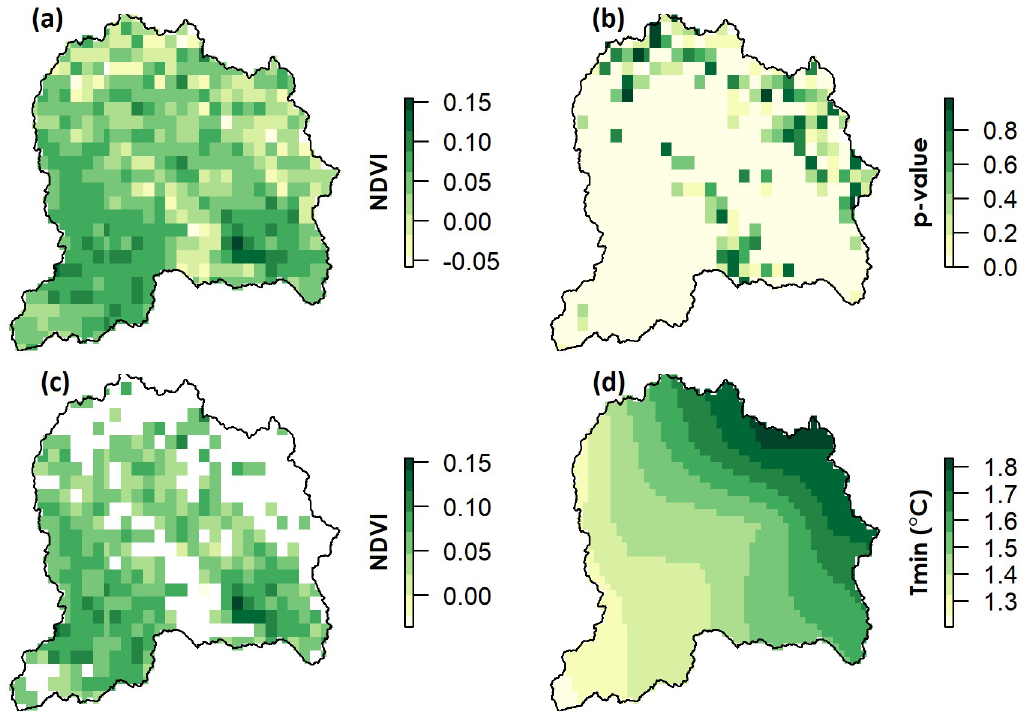
Fig 4. Pixel-wise trends in annual time series data of NDVI and Tmin during 1982 to 2015 (a) Sen’s slope of NDVI (b) p- values of NDVI, (c)significant trends (p < 0.05) in average annual slope (p < 0.01) of NDVI and (d) significant trends in annual average slope (p < 0.05) of